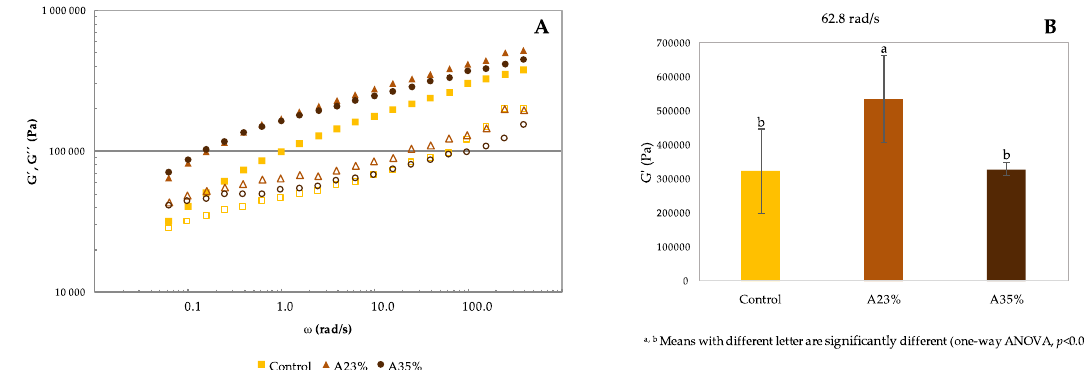
Figure 2. (A ): Mechanical spectra of GF doughs (control, A23%, A35%); G´ (storage modulus—filled symbol), G′′ (loss modulus—open symbol). ( B ): G′ values at 62.8 rad/s (10 Hz) for the same samples.